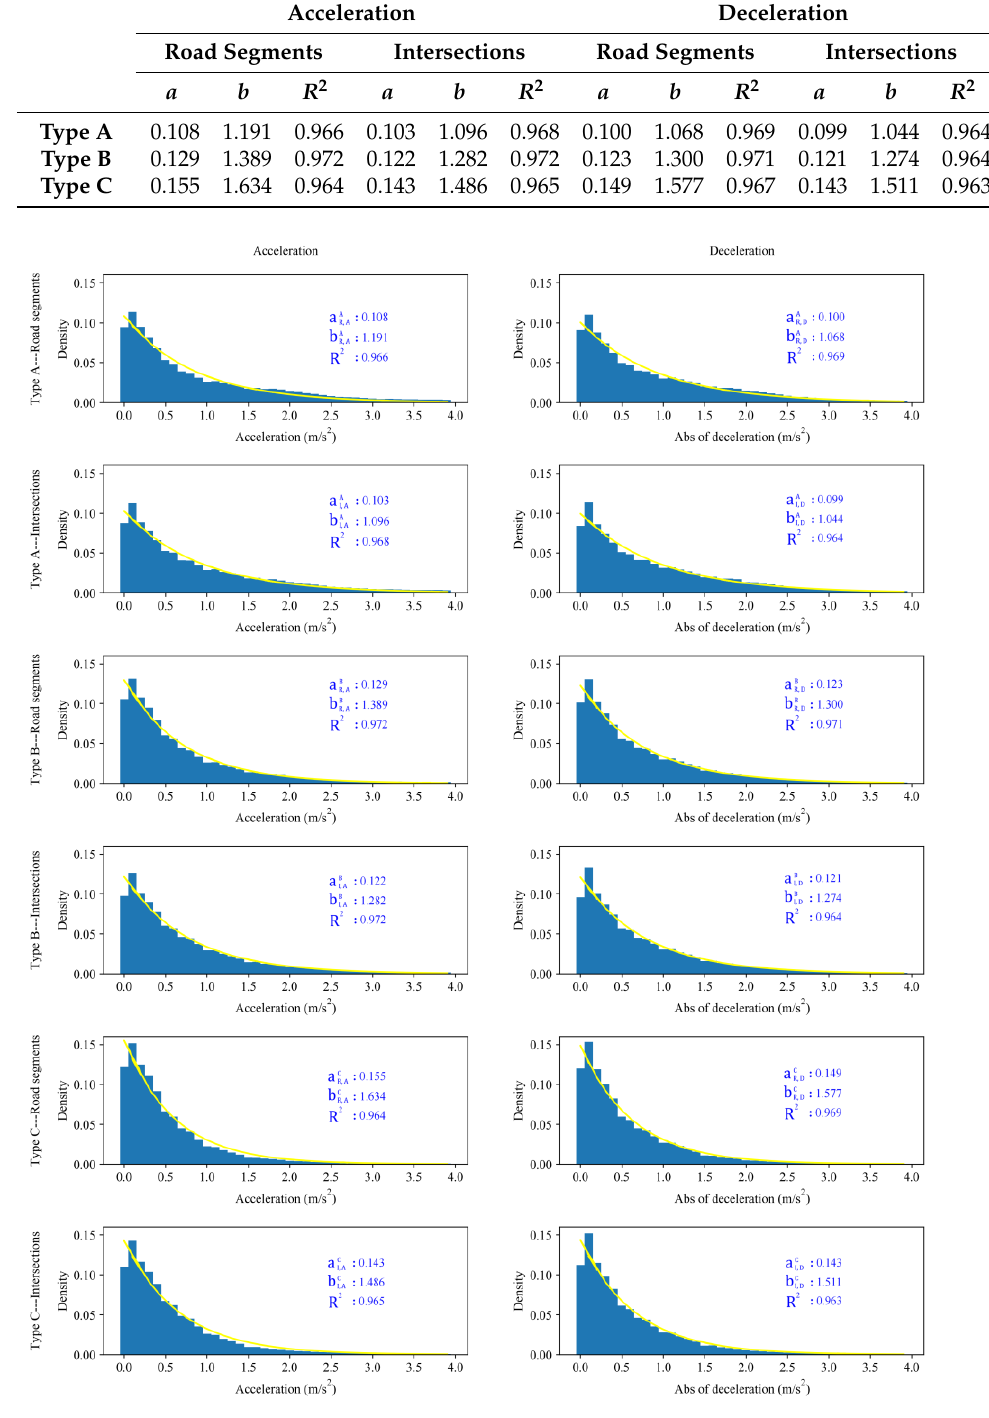
Figure 9. Acceleration and deceleration for different types of drivers in different driving environ- ments.